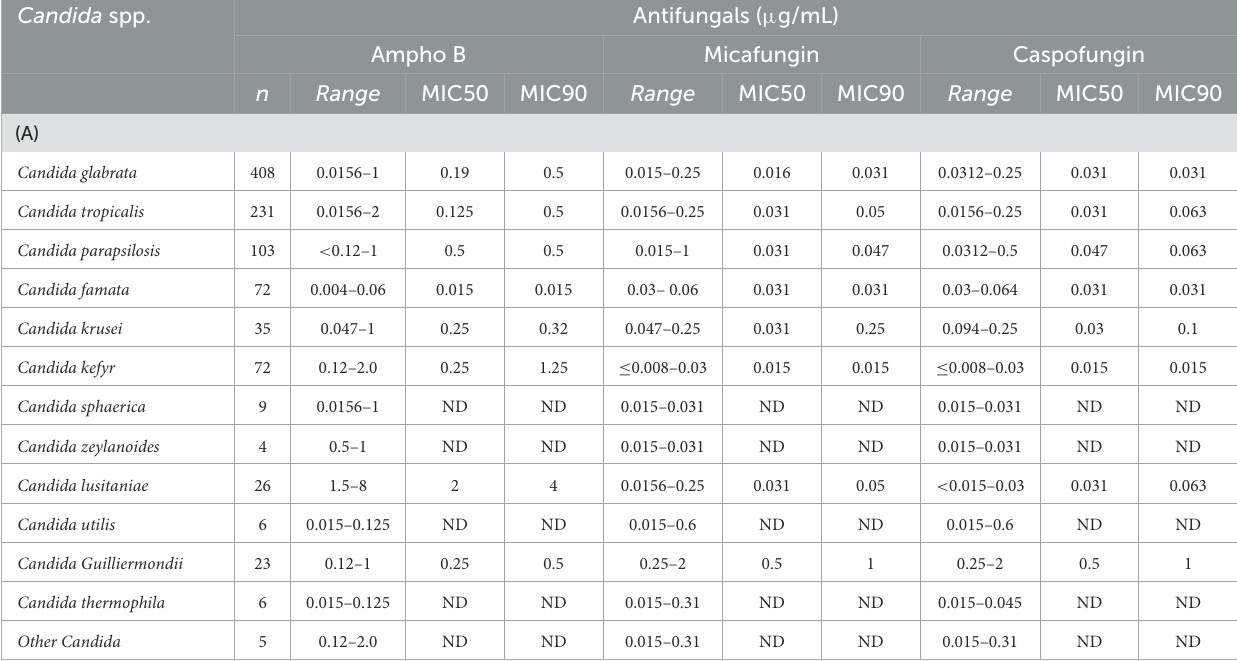
TABLE 2 Candida spp. isolates susceptibility to various antifungals. Candida